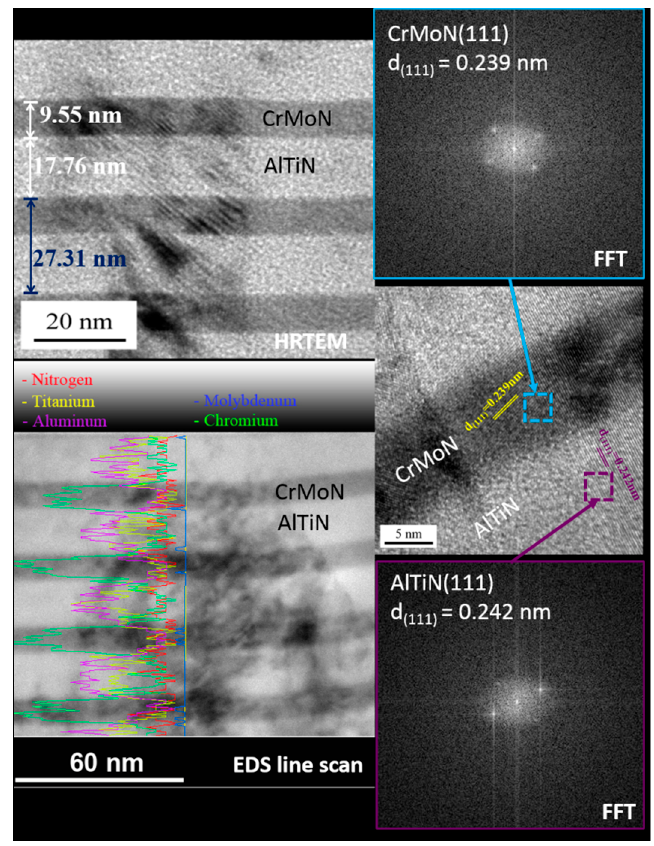
Figure 4. High-magnification cross-sectional high-resolution transmission electron microscope (HRTEM) images of the top AlTiN/CrMoN multilayers of the AlTiCrMoN-2 coating with energy-dispersive X-ray spectroscopy (EDS) line scan and fast Fourier transformation (FFT) of each AlTiN and CrMoN layer. Top left: HRTEM bright field image of the top AlTiN/CrMoN multilayers. Lower left: EDS line scan of the AlTiN/CrMoN multilayers. Top right: FFT image of the CrMoN layer. Lower right: FFT image of the AlTiN layer.